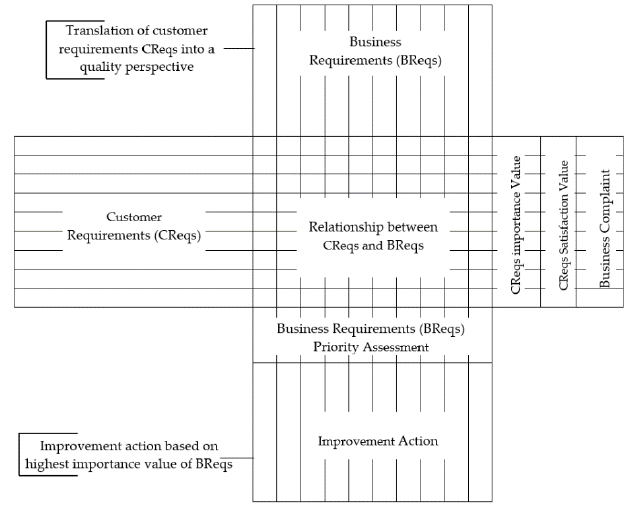
Figure 3. House of quality structure of business quality prioritization.